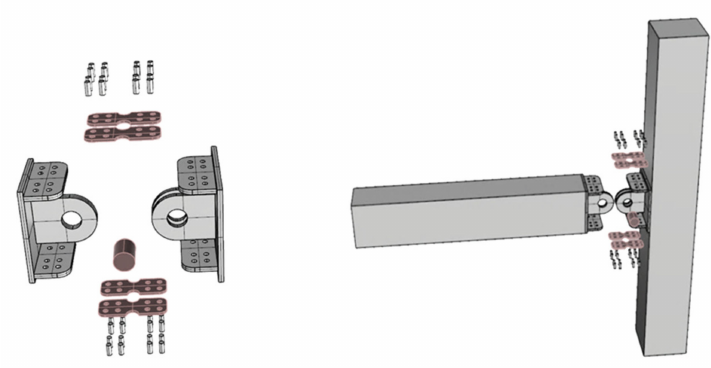
Figure 1. Details of PBSEC